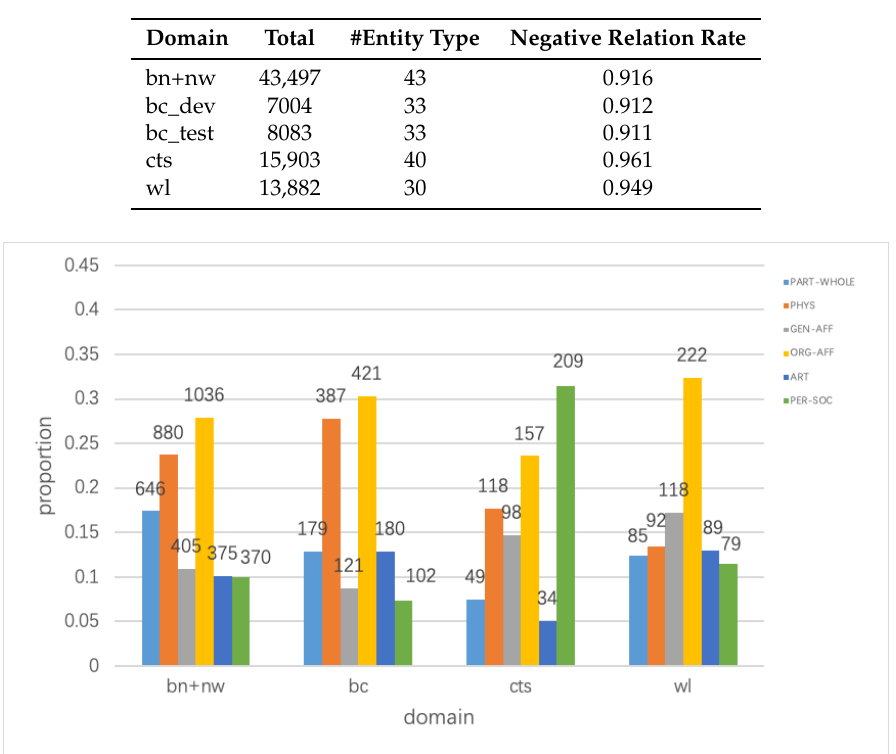
Figure 6. Relation distributions of different domains. Note that we ignore the NONE type because it accounts for a large portion in all three